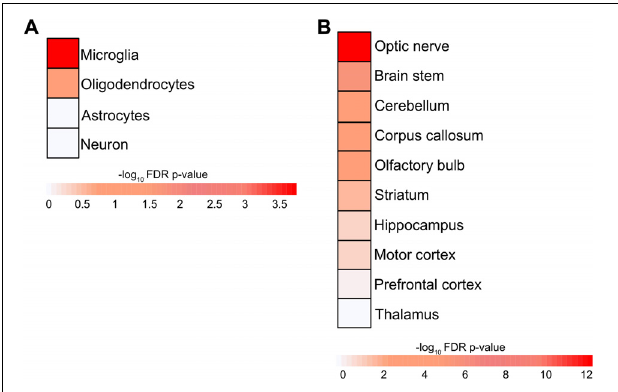
FIGURE 3 | Enrichment of brain cell types and region in RRi. (A) Heatmap representing the microglia, oligodendrocyte, astrocyte, neuron cell type enrichment. (B) Heatmap showing the enrichment of optic nerve, brain stem, cerebellum, corpus callosum, olfactory bulb, striatum, hippocampus, motor cortex, prefrontal cortex, and thalamus brain regions. The enrichments were assessed using Fisher’s exact test and negative log 10 ( Figure 5D ), olfactory-bulb-specific Rab infraction (obSRi) ( Figure 5E ), and striatum-specific Rab infraction (stSRi) ( Figure 5F ) subnets. The functional hubs of these